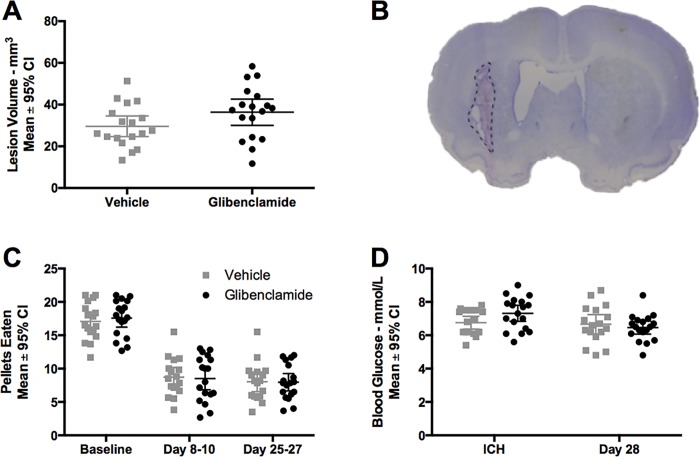
Experiment 3.Glibenclamide did not affect (A) tissue lost at a 28-day survival (P = 0.089). (B) Representative lesion volume image (vehicle group) demonstrating area of dead tissue (dashed line) and ventriculomegaly (larger ventricle). (C) reaching ability (P = 0.927, group main effect) and (D) blood glucose (P = 0.419, group main effect) we not impacted by glibenclamide. Sample size was n = 18/group.